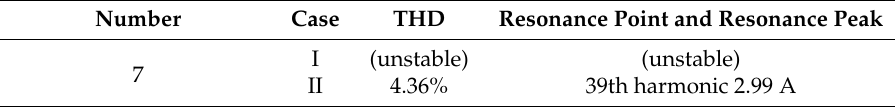
Table 6. Experimental results of the grid-connected current with seven parallel inverters. Number Case THD